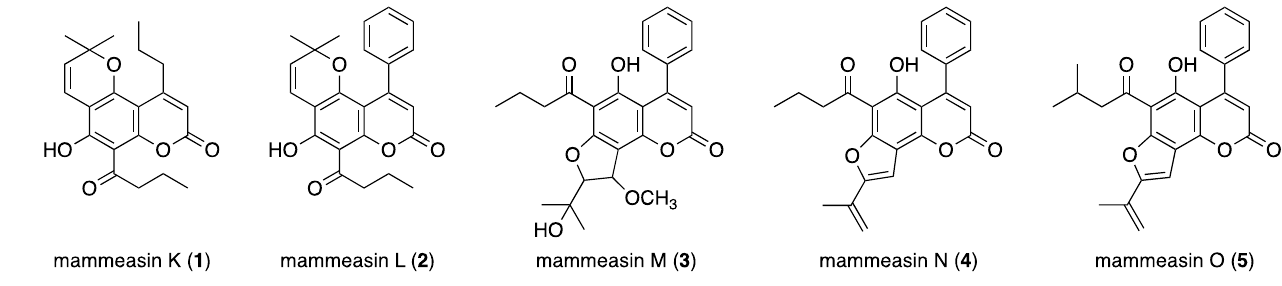
Figure 1. Structures of mammeasins K–O ( 1 – 5 )